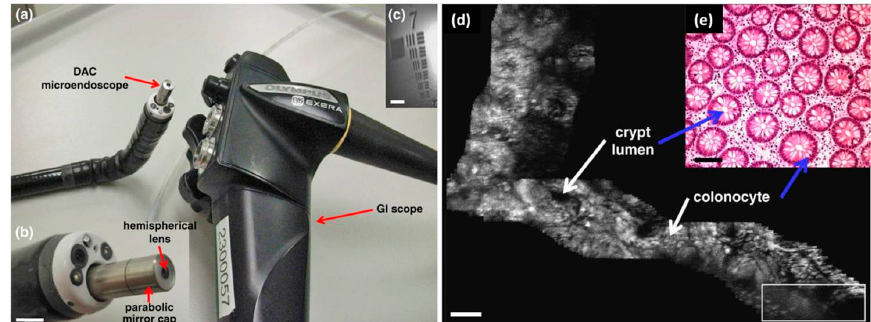
Figure 11. Outer diameter 5.5 mm DAC endomicroscope in the medical endoscope: ( a ) demonstration in an Olympus XT-160 medical endoscope; ( b ) distal end of the endomicroscope, scale bar = 5 mm; ( c ) resolution test on USAF target; ( d ) mosaicked large FOV en-face images of normal colonic mucosa at a depth of 60 µm; and ( e ) a representative histologic image stained with hematoxylin and eosin (H&E) of normal colonic mucosa, scale bar = 100 µm, the white rectangle represents an individual en face image (362 × 134 µm 2 ) obtained using the MEMS based DAC endomicroscope (Reproduced with permission from SPIE [76]).